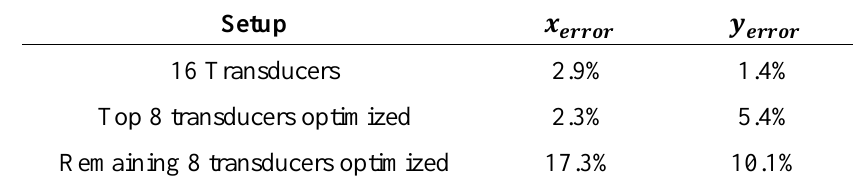
Table 2. The damage location identification accuracy comparing among three manners of transducer